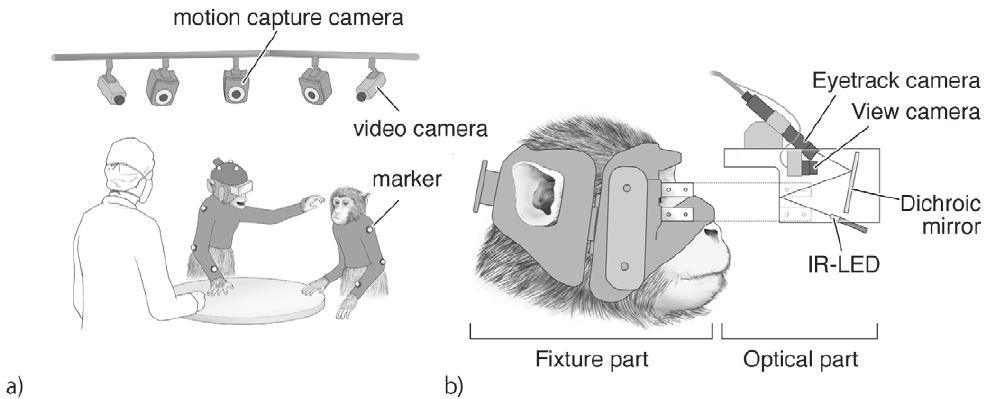
Figure 2. Experimental environment and eye tracking system. a) Sketch of the recording environment of MDR while the monkeys performed a social food-grab task. The monkeys wore an elastic motion capture suit tailored for each monkey. The monkeys sit on a primate chair with the lower body including the legs covered and restrained by a box and a collar fixed to a pole attached to the chair. Two monkeys were placed around a table. Reflective markers for motion capture were attached at the joints of both arms (shoulder, elbow and wrist) and the head. One monkey (left) whose ECoG activity was recorded wore a head-free eye-tracking system. Motion capture and video cameras were hung from the ceiling. b) Illustration of the head-free eye-tracking system. The eye-tracking system comprises two parts: a fixture part and an optical part. The fixture part was made of dental acrylic that fit the monkey’s facial surface. The optical part had an infrared (IR) LED, dichroic mirror, eye-track camera, and view camera. The fixture part is tailored for each monkey and is attached to the optical part by screws.